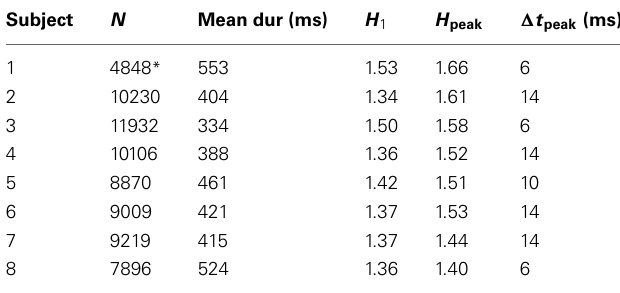
Table 1 | Summary of subject fixation